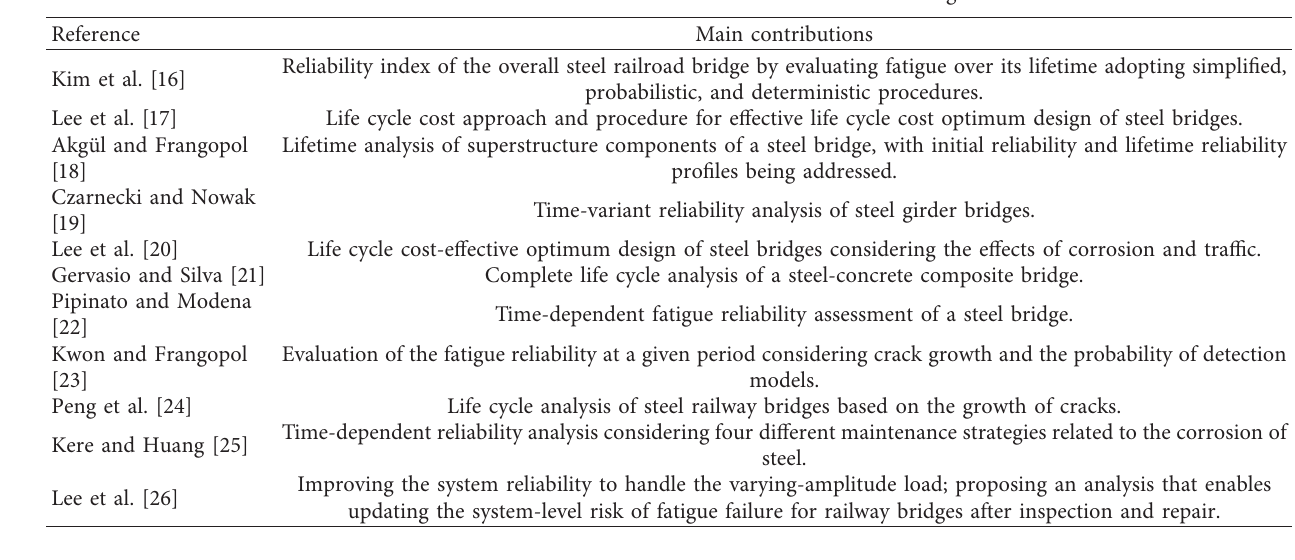
Table 1: Research works in the field of assessment of steel